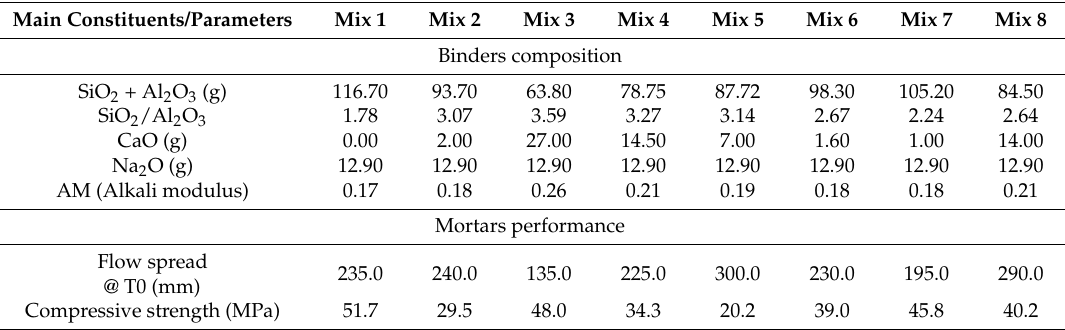
Table 5. Analysis of the composition of optimized alkali-activated